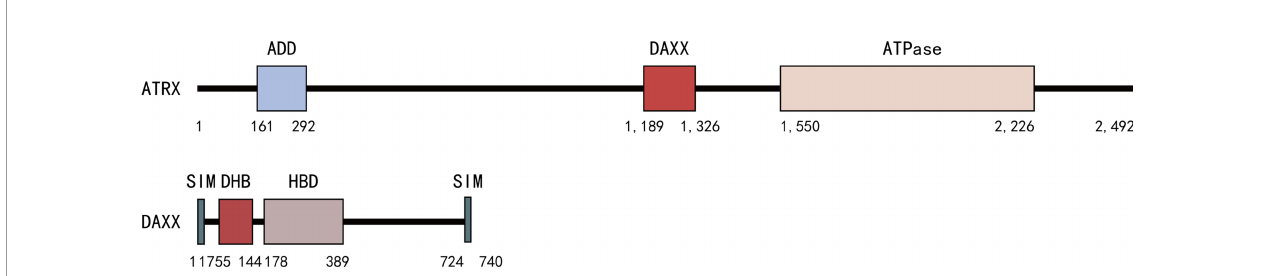
FIGURE 2 | DAXX binds to the linker region of ATRX (residues between 1,189 and 1,326) located between the ADD and ATPase domains through its N-terminal DHB